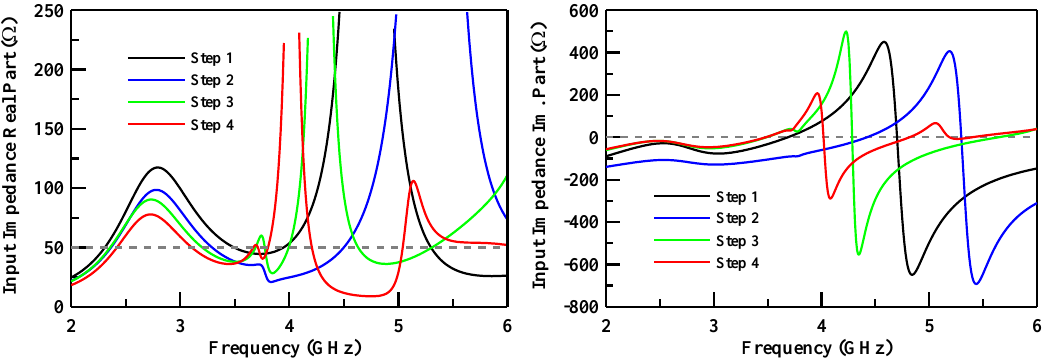
Figure 8. Variations of the impedance using the different models in the optimization processes.